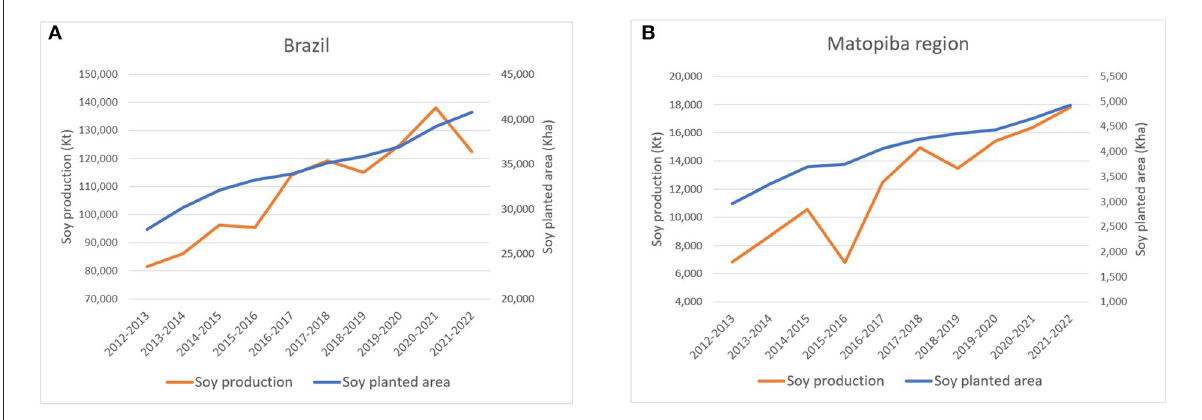
FIGURE2 Historical graph of the soy planted area (in thousand hectares) and the soy production (in thousand tons) for the period between 2012 and 2022 in (A) Brazil and (B) Matopiba region. The estimate made for the period between 2021 and 2022 was made in April 2022. Source: adapted from CONAB